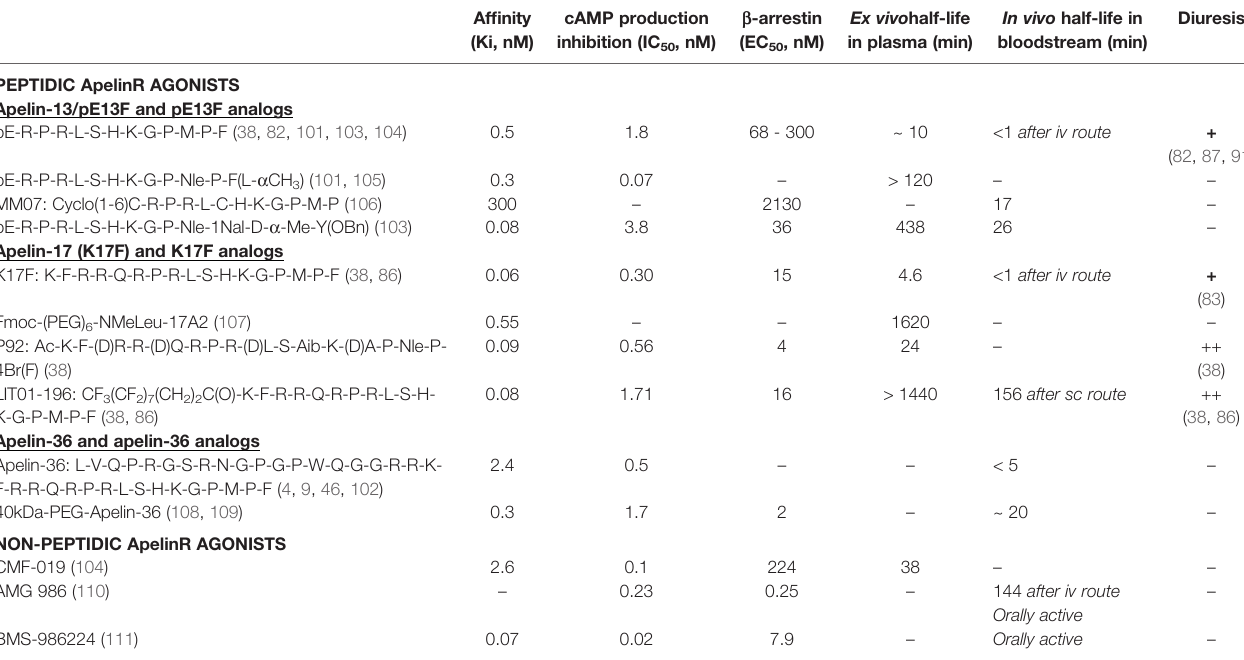
TABLE 1 | Development of Apelin-R